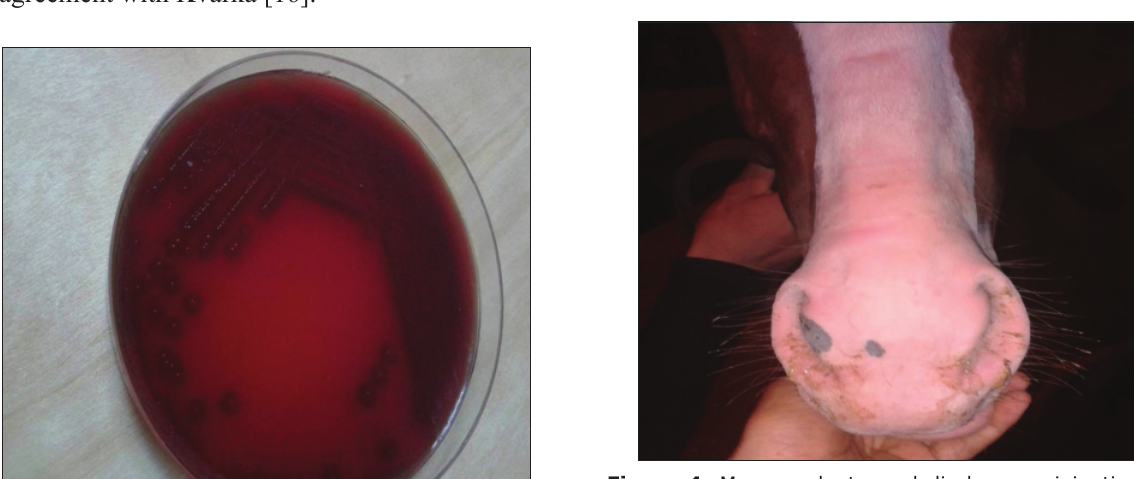
Figure-4: Mucopurulent nasal discharge originating from infected retropharyngeal lymph node in strangled Arabian horse.